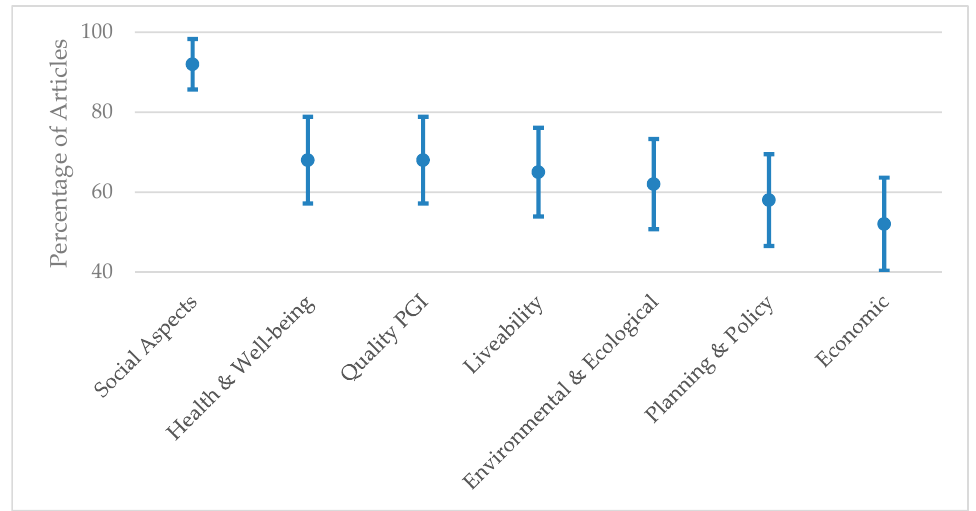
Figure 7. Rate of reporting (± 95% confidence intervals (CIs) of the proportions) of the research focus for the contribution that PGI makes to urban livability identified by this review (n = 71). Percentages add to greater than 100% as articles that report multiple focuses are reported in more than one category.